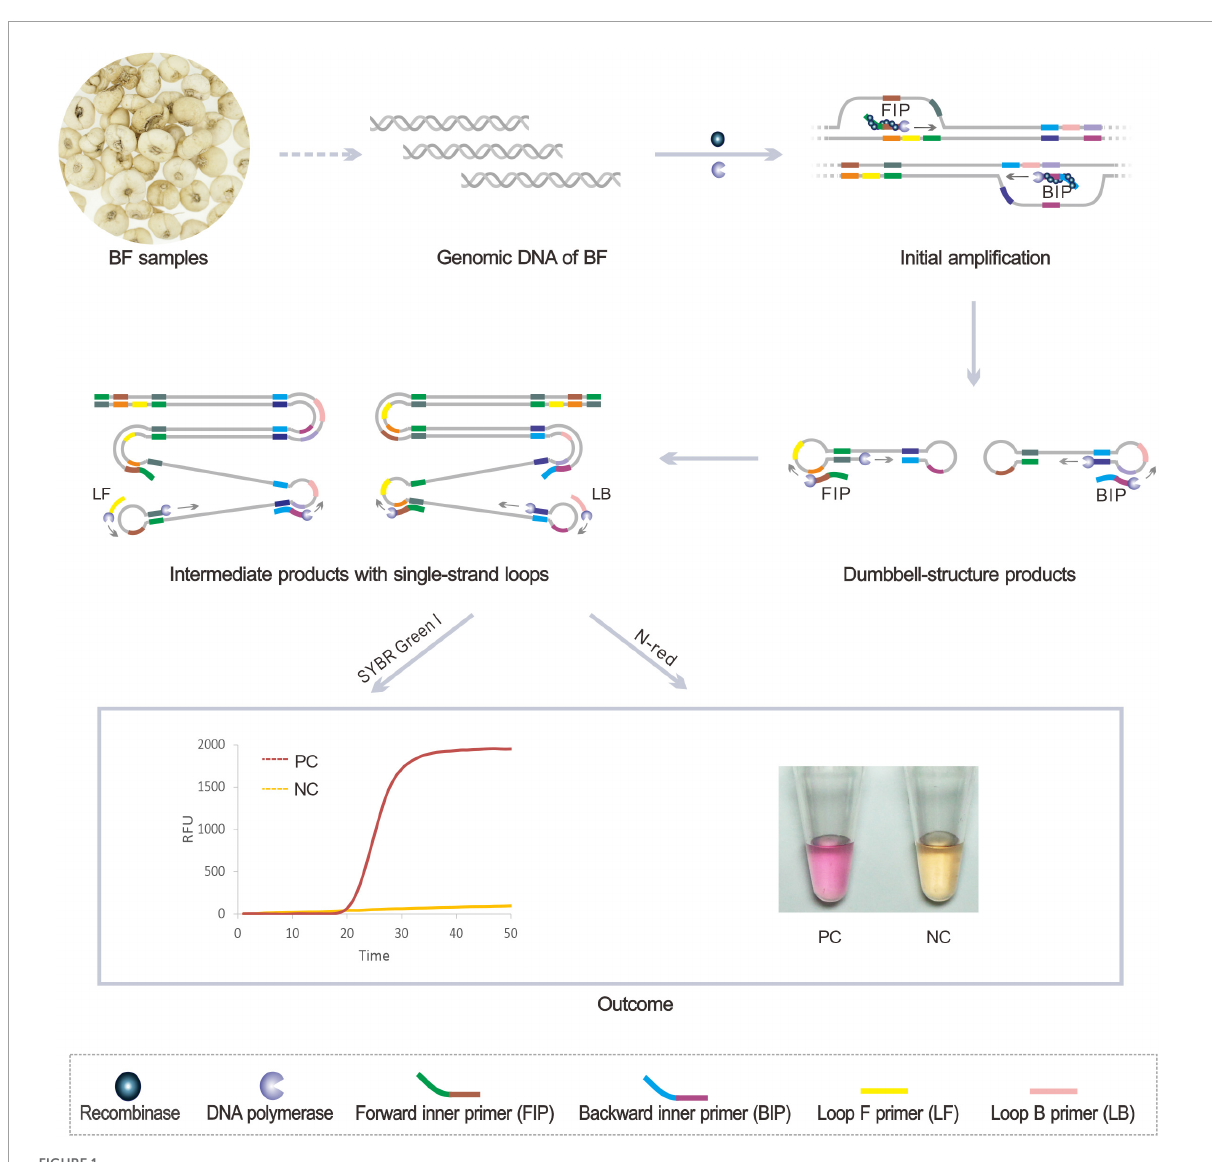
FIGURE1 Schematic diagram of the Recombinase Assisted Loop-mediated isothermal DNA Amplification detection method of BF samples. PC, positive control with DNA target; NC, negative control without the